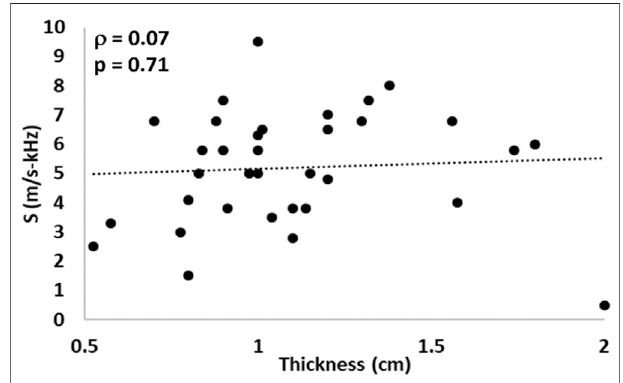
FIGURE 11 | Shear wave dispersion parameter S vs. cervical thickness in the NHP model. Pearson ’ s correlation values was ρ (cid:2) 0.07 ( p (cid:2)